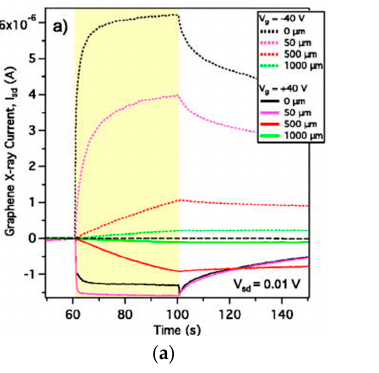
Figure 8. ( a ) The “beetle” (left) and bowtie (right) antennae and ( b ) the log-periodic, circular